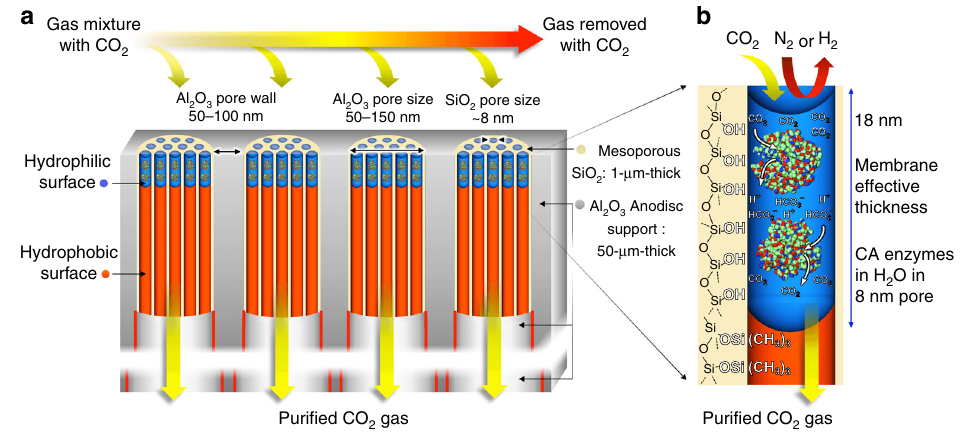
Fig. 2 Enzymatic liquid membrane design and mechanism of CO 2 capture and separation. a The membrane is fabricated by formation of ~1- µ m-deep oriented arrays of 8 nm diameter cylindrical silica [SiO 2 ] mesopores within the larger 50 – 150-nm pore channels of a 50- μ m-thick porous alumina [Al 2 O 3 ] Whatman © Anodisc support. b Using atomic layer deposition and oxygen plasma processing (described in text and Fig. 4) the silica mesopores are engineered to be hydrophobic (trimethylsilyl (Si(CH 3 ) 3 ) surface groups) except for an 18-nm-deep region at the pore surface, which is hydrophilic ( ≡ Si-OH surface groups). Via capillary condensation, CA enzymes and water spontaneously fi ll the hydrophilic mesopores to form an array of nano-stabilized CA enzymes with an effective CA concentration >10× of that achievable in solution. CA catalyzes the capture and dissolution of CO 2 as carbonic acid (HCO 3 – ) moieties at the upstream surface and regeneration of CO 2 at the downstream surface (see Fig. 1c). The high concentration of CA and short diffusion path length maximizes capture ef fi ciency and fl